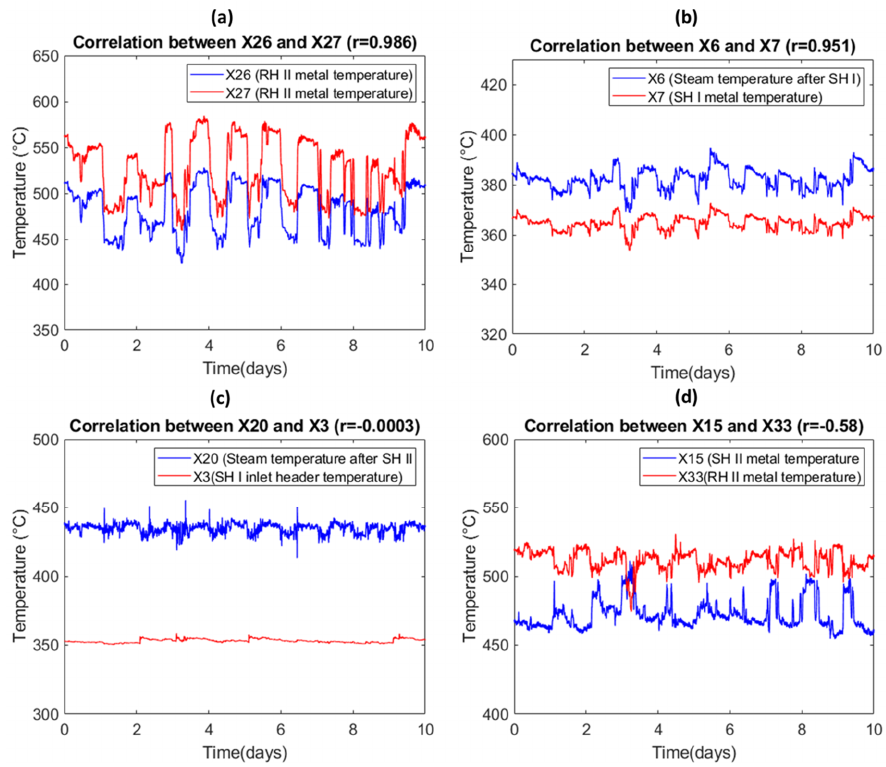
Figure 9. Correlations between different sensors with different correlation coefficients: ( a ) r = 0.951, ( b ) r = 0.606, ( c ) r = −0.003, ( d ) r = −0.58.